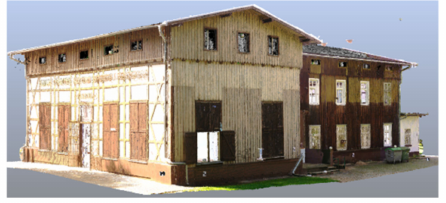
Figure 14. Casino elevation 3D scan.